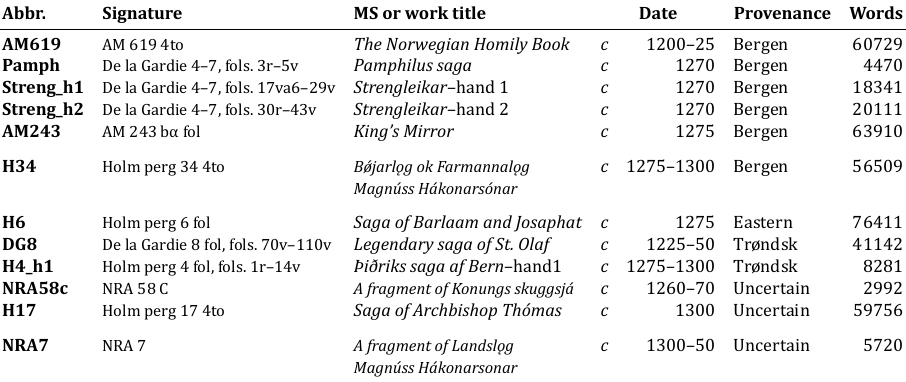
Table 1: The elicited manuscripts’ size, estimated date, and estimated